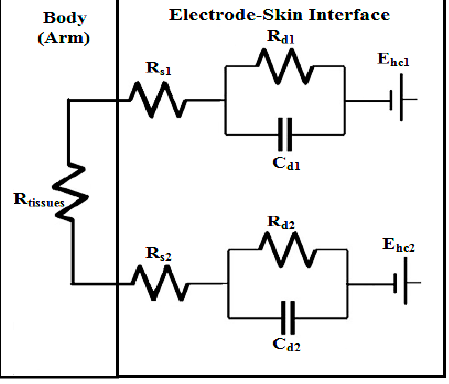
Figure 5. The simplified schematic diagram for the electrodes system used in the study.